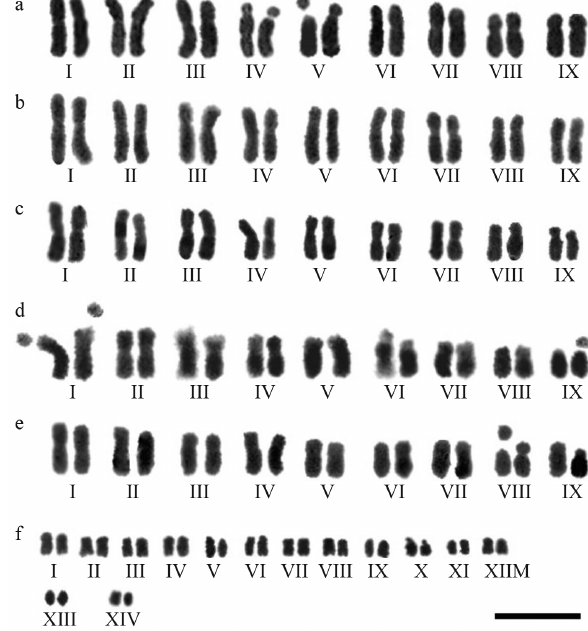
Figure 4 - Karyograms of some species of the Tribe Trimezieae from northeasternBrazil.(a) Neomaricacandida ;(b) N.gracilis ;(c) N.humilis ; (d) N. northiana ; (e) Neomarica sp. (2 n = 18); (f) N. cf. paradoxa (2 n = 28). The bar corresponds to 10 (cid:2)